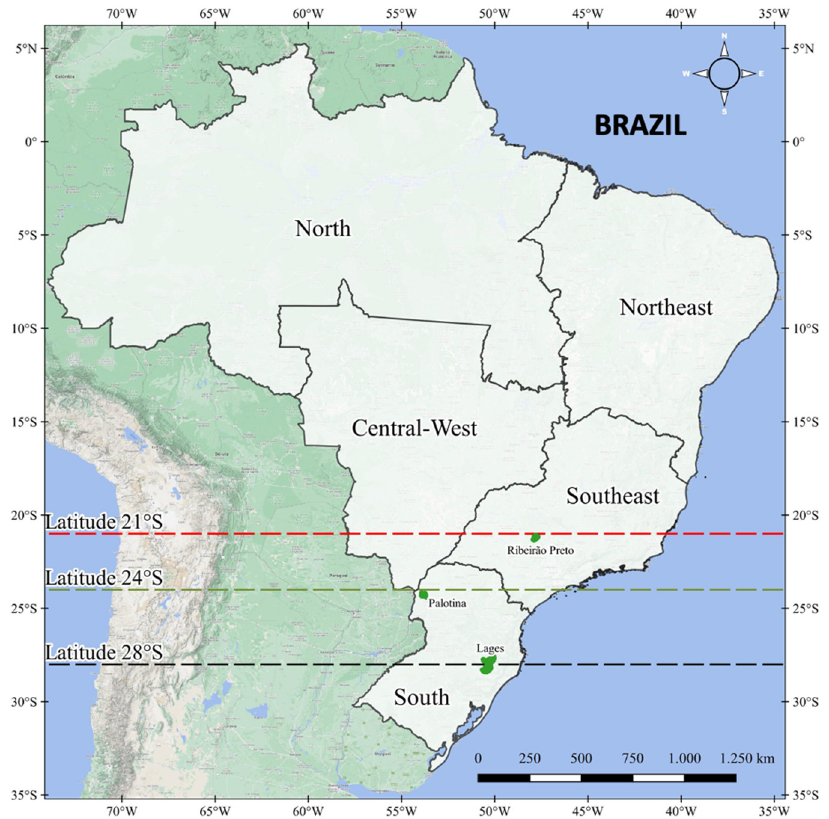
Figure 2. Map of Brazil including some emerging hop-growing areas located at different latitudes: Lages, Santa Catarina state (28° S, 50° W, elevation 916 m a.s.l., Cfb climate, humid subtropical with temperate summer); Palotina, Parana state (24° S, 54° W, elevation 320 m a.s.l., Cfa climate, humid subtropical with hot summer); and Ribeirão Preto, São Paulo state (21° S, 48° W, elevation 516 m a.s.l., Aw climate, tropical with dry winter).